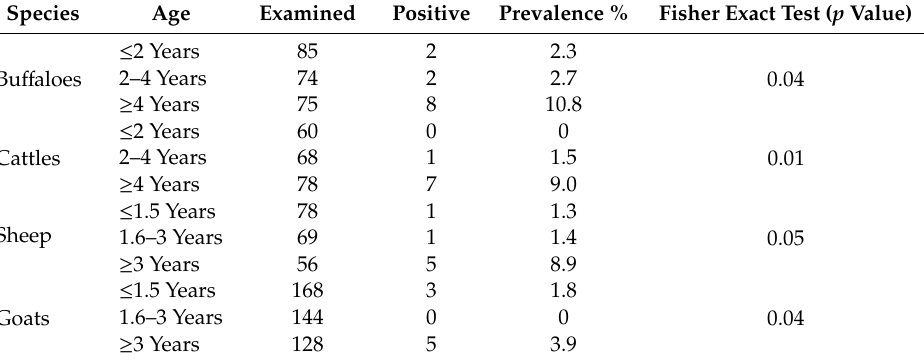
Table 2. The e ff ect of species and age on the prevalence of brucellosis in Punjab, Pakistan. Species Age Examined Positive Prevalence